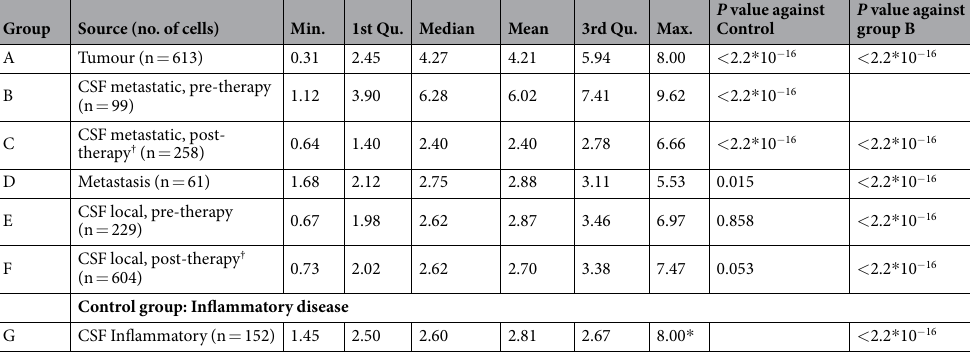
detect occult metastasis at diagnosis using a simple CSF examination has important therapeutic implications. FLIM also makes disease follow-up possible with repeated CSF sampling for early detection of recurrence. We found 3 different FLT measurements in CSF cells, clearly differentiating normal inflammatory non-malignant cells from malignant cells. The median FLT of metastatic CSF samples was significantly longer than that of the other CSF samples. One of the advantages of this study is that it includes 17 children with long-term and intensive follow-up, with a mean of 3 examinations per child and a total of 58 FLT measurements. Therefore, FLT results could be compared to the clinical, histological and imaging results at each time point. FLT was found to be reliable, repro- ducible, and highly correlated to the clinical course, treatment, and outcome. According to the literature, about one-third of children with medulloblastoma have metastatic disease within the CNS at diagnosis 6 . The presence of CNS metastases is assessed in two ways: prior to surgery by MRI of the whole craniospinal axis and approximately 2 weeks after surgery by cytologic study of CSF samples. Lumbar puncture to collect CSF cannot be performed before surgery because of the risk of brain stem herniation. In patients with metastatic disease at diagnosis, treatment is usually upgraded to include a higher dose of craniospi- nal irradiation and possibly autologous bone marrow transplantation following high-dose chemotherapy.